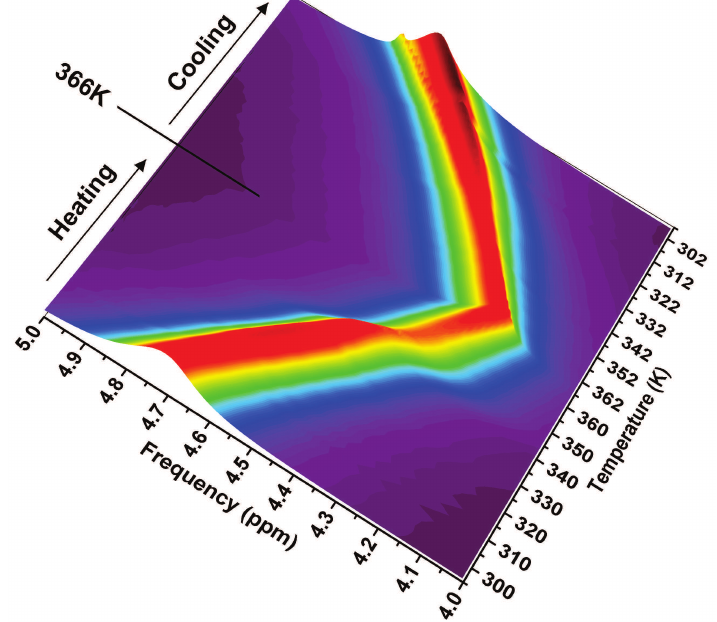
Figure 4. Three-dimensional color map of 1 H HR-MAS spectra in the chemical shift region of the water NMR signal for hydrated lysozyme during the complete thermal cycle showing the irreversible denaturation: heating from 296 to 366 K and then cooling down to 298 K with 2 K steps. Note the sharp inflection at about 345 K only during the heating